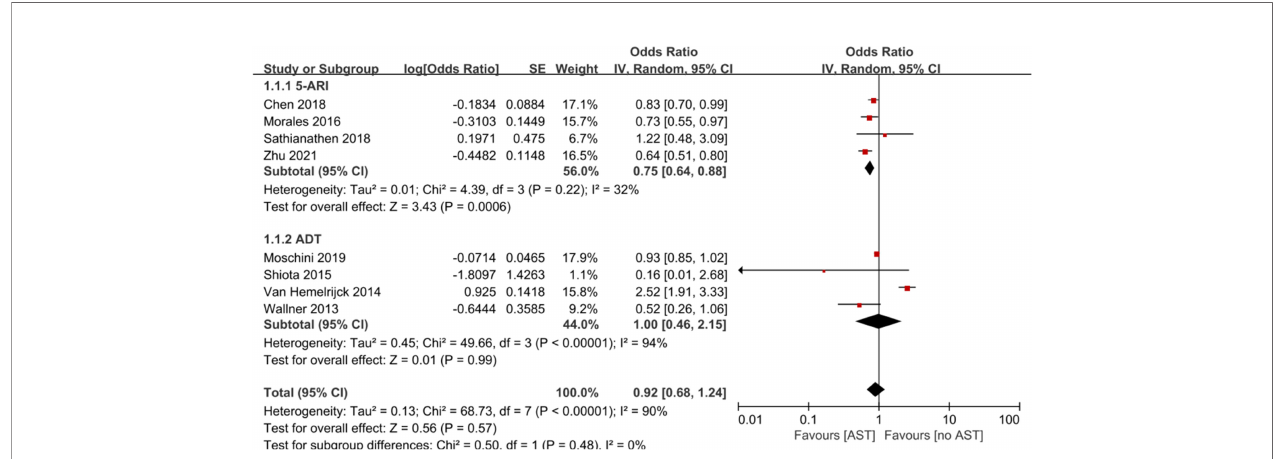
FIGURE 2 | Forest plots showing the effect of AST on bladder cancer incidence. AST, Androgen suppression therapy; 5-ARI, 5-alpha reductase inhibitor; ADT, Androgen